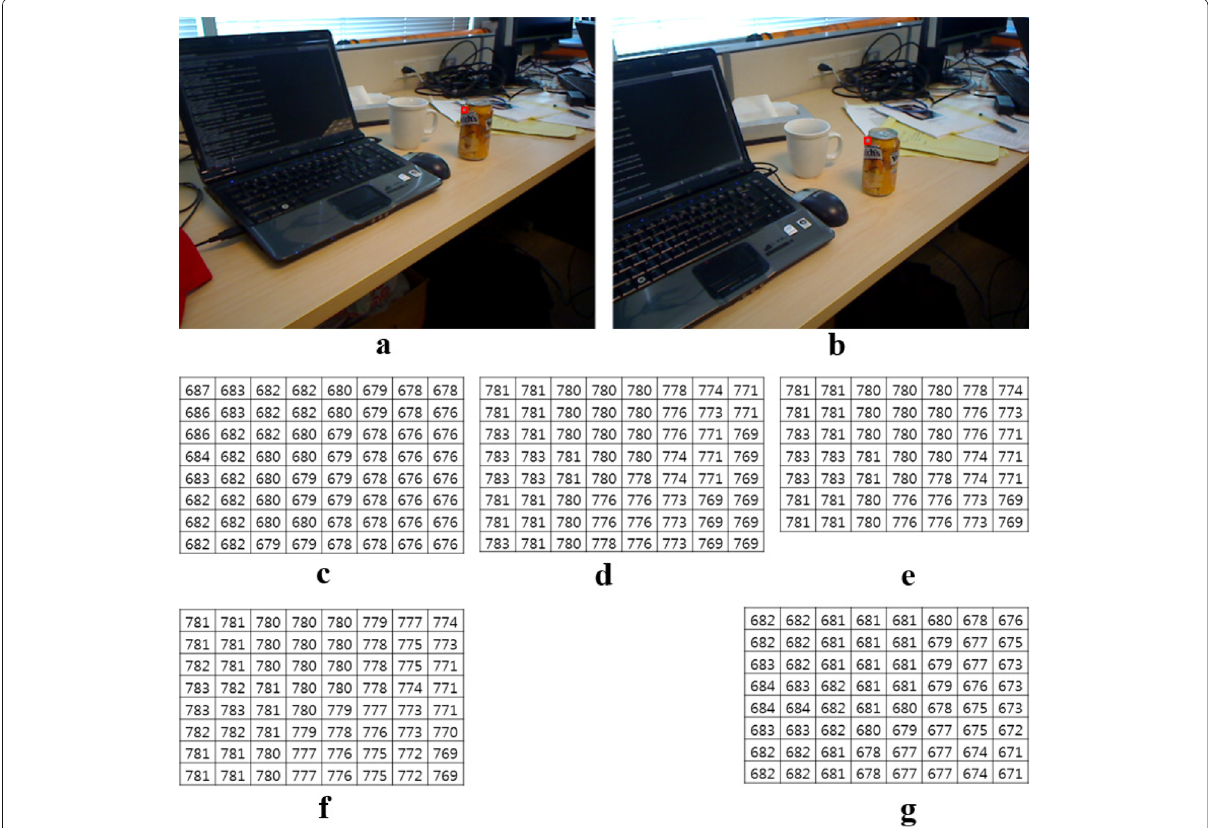
Fig. 8 3D scaling in proposed method for depth video. a Color current picture, b color reference picture, c current block, d reference block, e 7 × 7 reference block, f size-scaled block, and g value-scaled